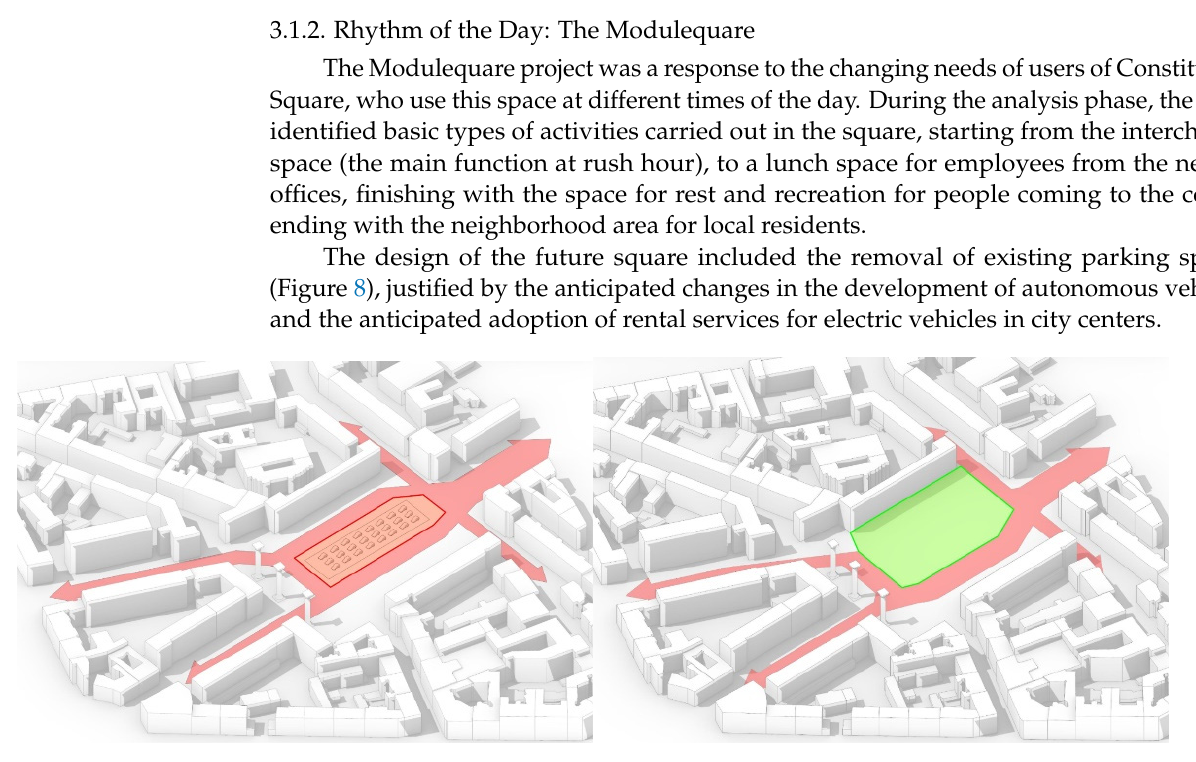
Figure 8. Diagram illustrating the proposed reorganization of the traffic through the square, aiming at the improvement of pedestrian communication. ( Left ): current state. ( Right ): future state.